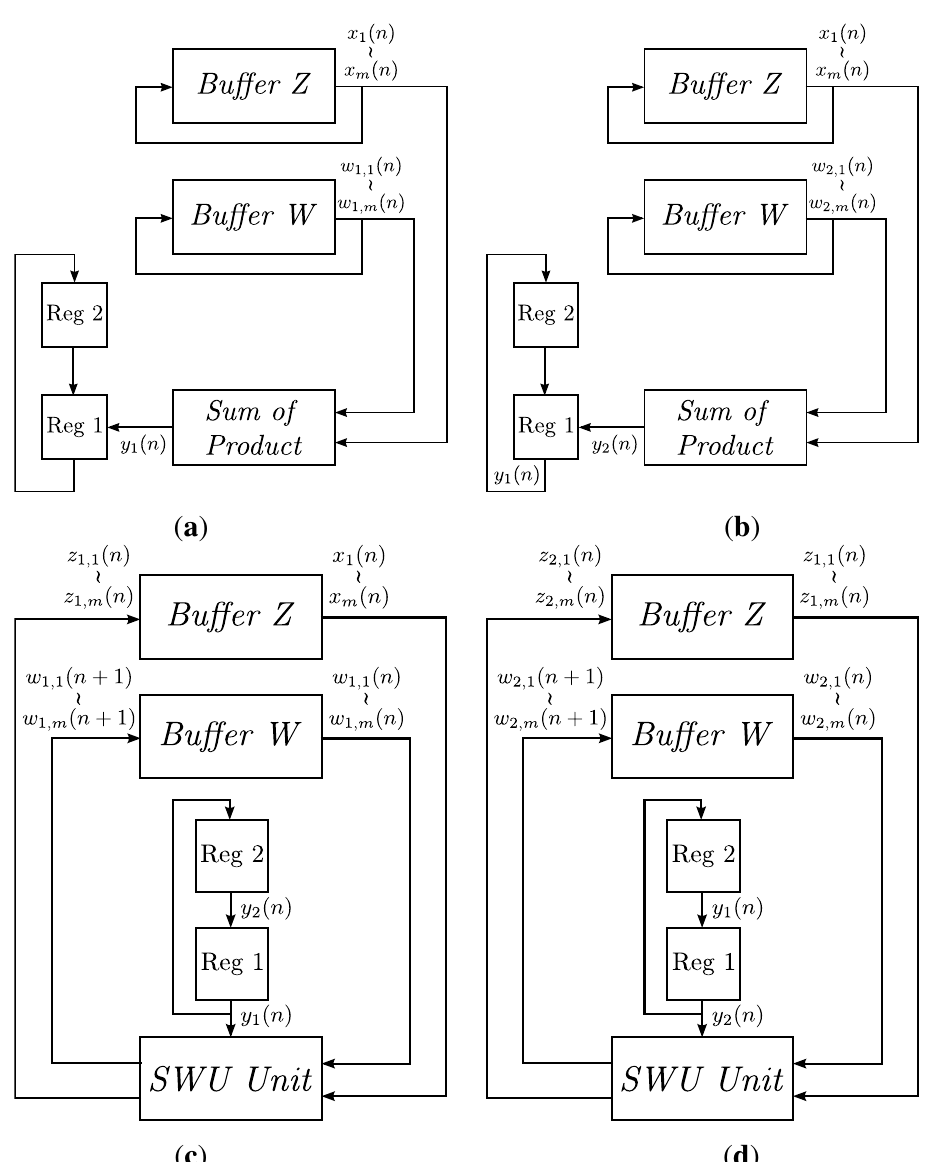
Figure 8. The operations of the basic single-channel GHA circuit for feature extraction for p = 2 : ( a ) the computation of y ( n ) using the SOP circuit; ( b ) the computation of y 1 ( n + 1) using the SWU unit; ( d ) the computation the SOP circuit; ( c ) the computation of w 1 ( n + 1) using the SWU of w 2